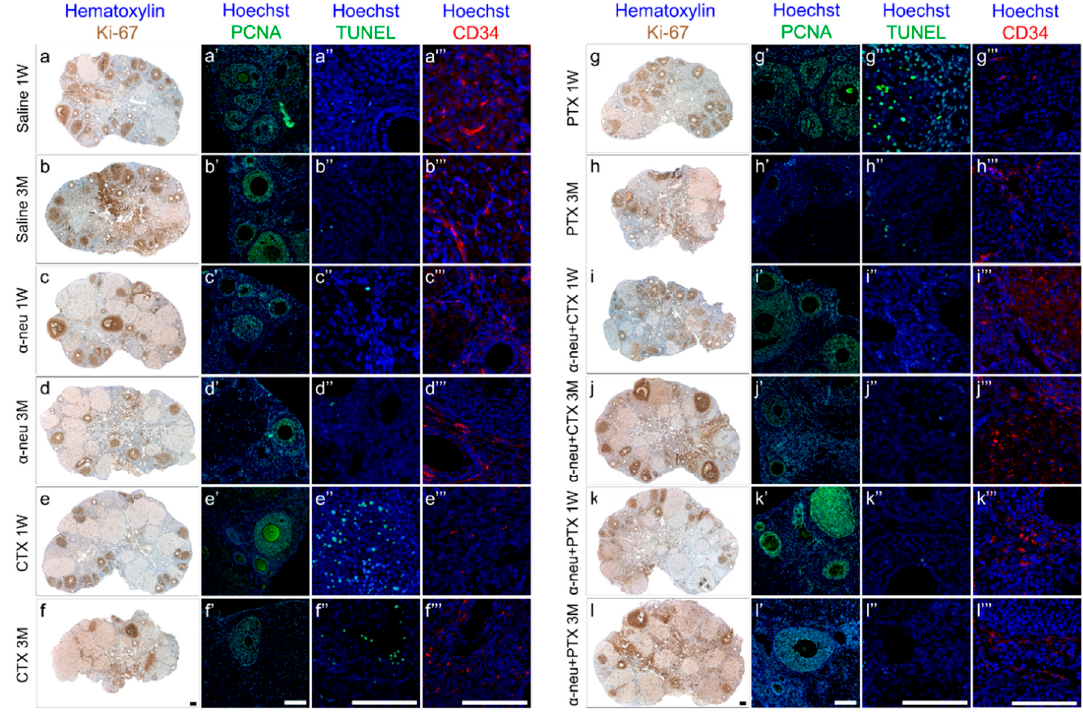
Figure 2. Ovarian proliferation, apoptosis, and vascular state in mice after chemotherapy treatment with or without anti-HER2 / neu. Mature female mice were treated as described in the legend of Figure 1. Ovaries were excised from mice one week (1 W) or three months (3 M) after treatment, fixed, paraffin-embedded and serially sectioned for immunohistochemistry, immunofluorescence and terminal transferase-mediated deoxyuridine 5-triphosphate nick-end labeling (TUNEL). Representative bright field images of ovaries stained with Ki-67 (brown; ( a – l )) and representative fluorescence images of ovaries stained against PCNA (green; ( a’ – l’ )), TUNEL (green; ( a” – l” )) or CD34 (red; ( a”’ – l”’ )). Bars = 100 µm.